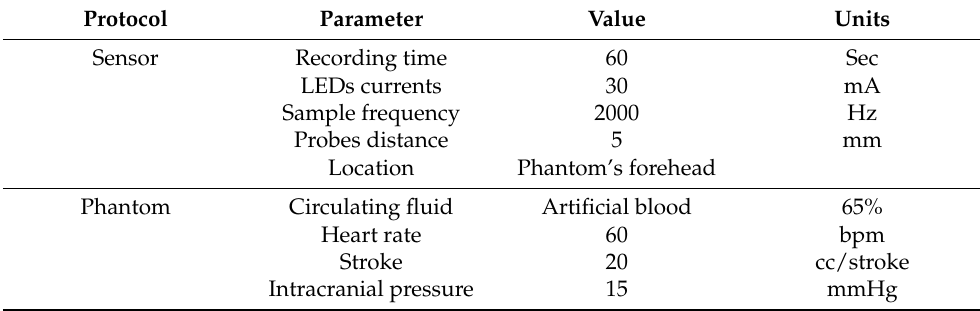
Figure 5. The head phantom consists of a brain, skull, cerebrospinal fluid, and blood circulation. The sensor on top of the forehead shines light to reach the pulsatile vessels of the brain and receives light that correlates to oxygenation and ICP. Table 2. Quality evaluation setup